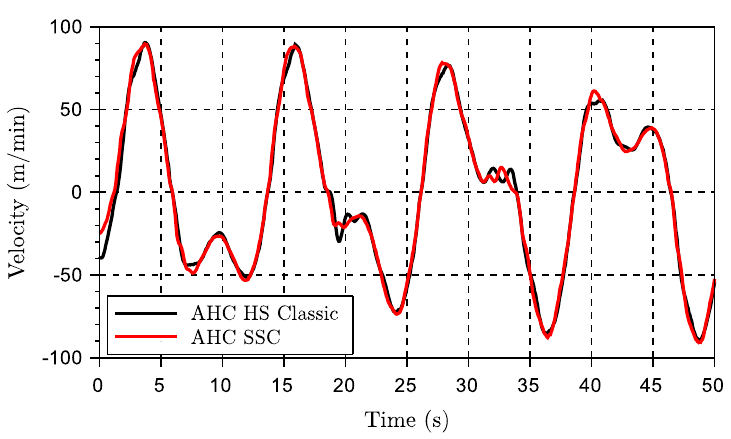
Figure 23. Crane’s tip position for scenario 3.